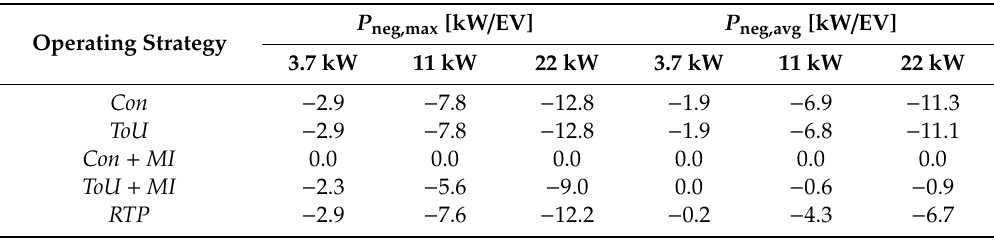
Table 6. Maximum and average negative flexible power for five operating strategies and three maximum charging